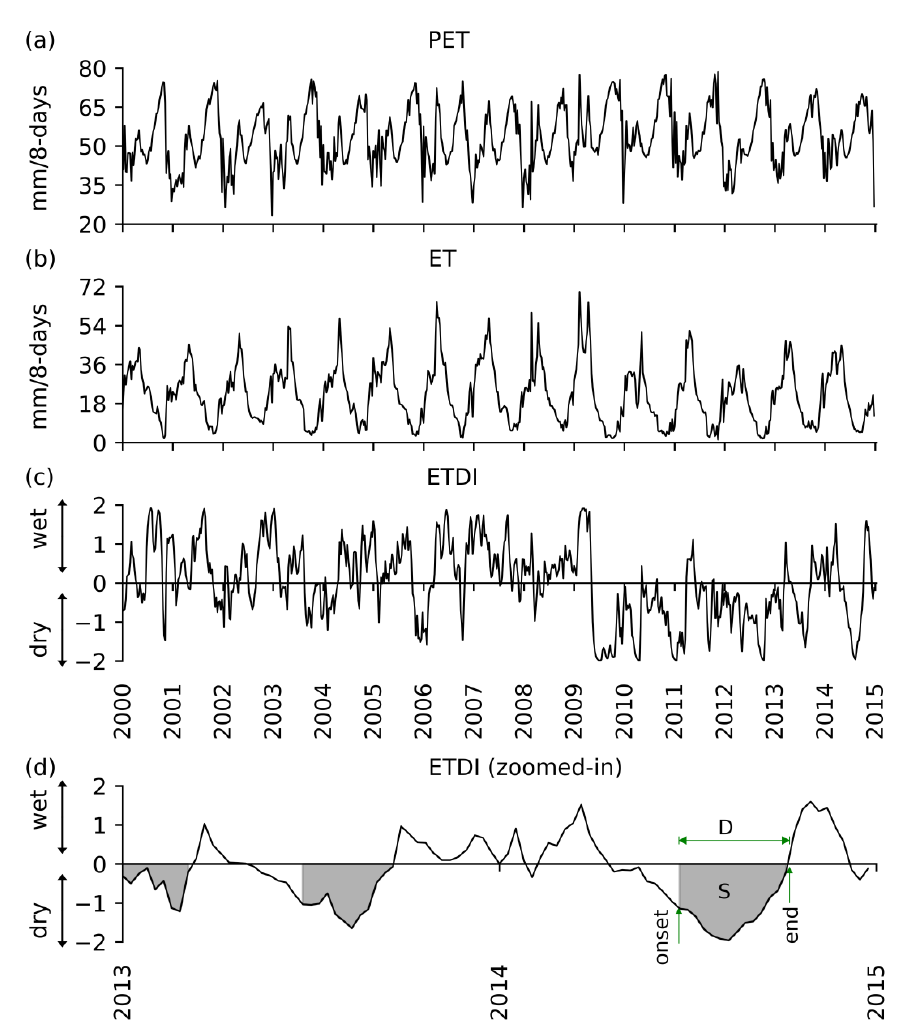
Figure 4. Graphical representation of data and drought analysis on the example of pixel X in Figure 2. ( a ) Potential evapotranspiration (PET). ( b ) Evapotranspiration (ET). ( c ) Evapotranspiration deficit index (ETDI). ( d ) Zoomed-in version of ETDI for illustrating onset and end of drought events (shaded regions), drought duration (D), and drought severity (S).